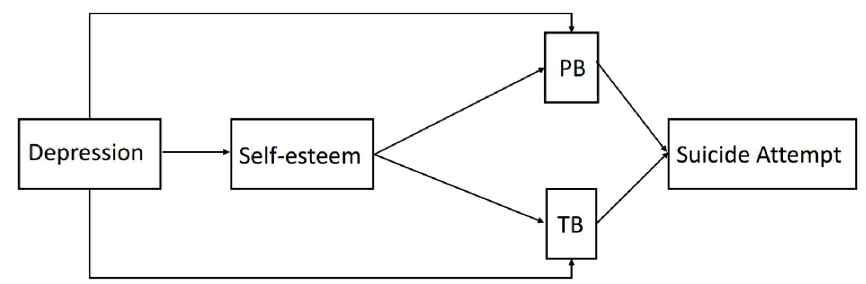
Figure 3. The alternative model that self-esteem predicts TB and PB parallelly.